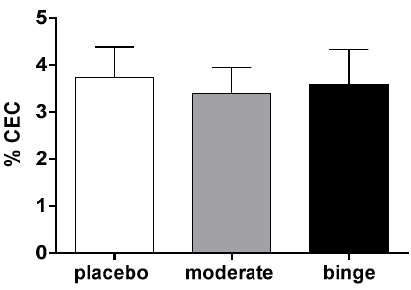
Figure 3. Effect of moderate and binge alcohol consumption on plasma cholesterol efflux capacity CEC. Murine peritoneal macrophages (MPM) were cholesterol enriched with 25 mg/mL acetylated LDL (AcLDL) and radiolabeled with [ 3 H]-cholesterol 2 µ Ci/mL. After an equilibration period of 18 h, cells were exposed to 0.5% plasma from mice treated with placebo for 5 h, moderate or binge alcohol as described in the Methods Section. Efflux is expressed as cpm in medium/cpm of time zero × 100 (values are the mean of a triplicate). Data are expressed as mean ± SEM (n = 9–10 mice per group). Results were analyzed using one-way ANOVA followed by Tukey’s multiple comparison test among groups.